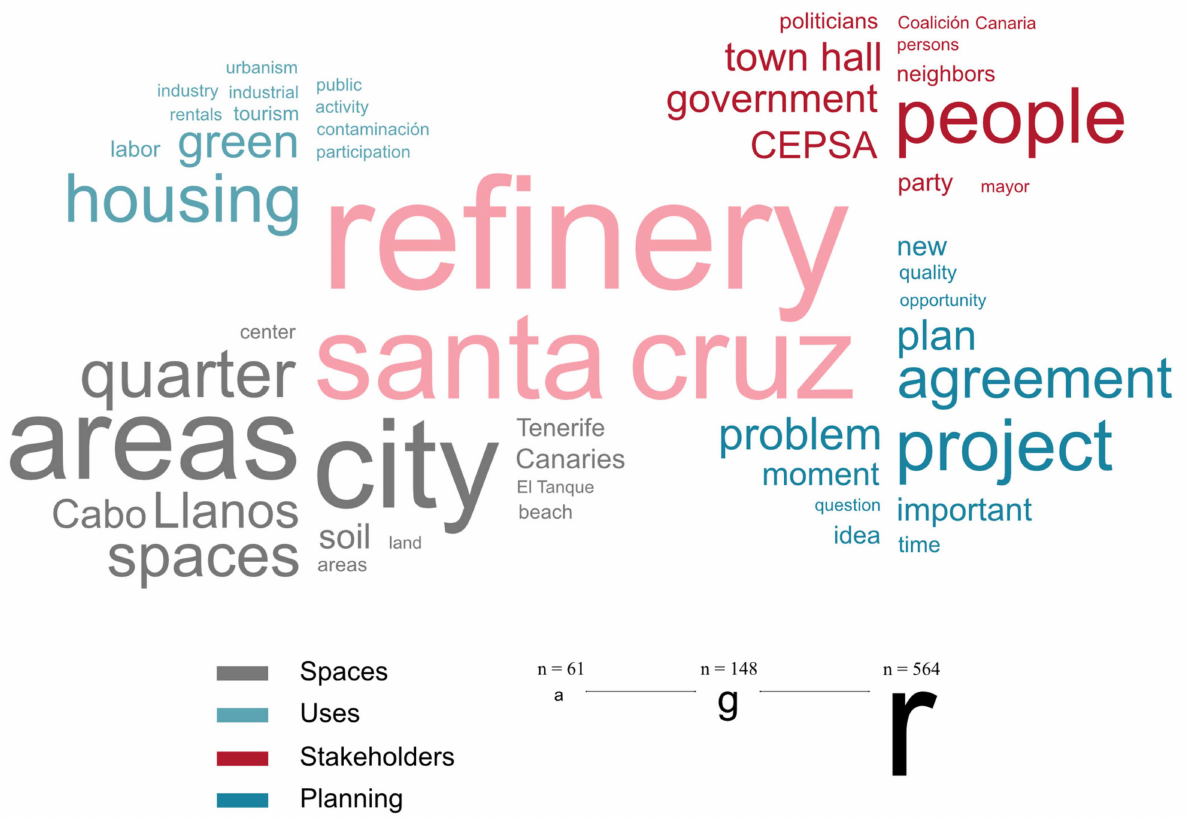
Figure 2. Word cloud based on the 18 transcribed interviews.